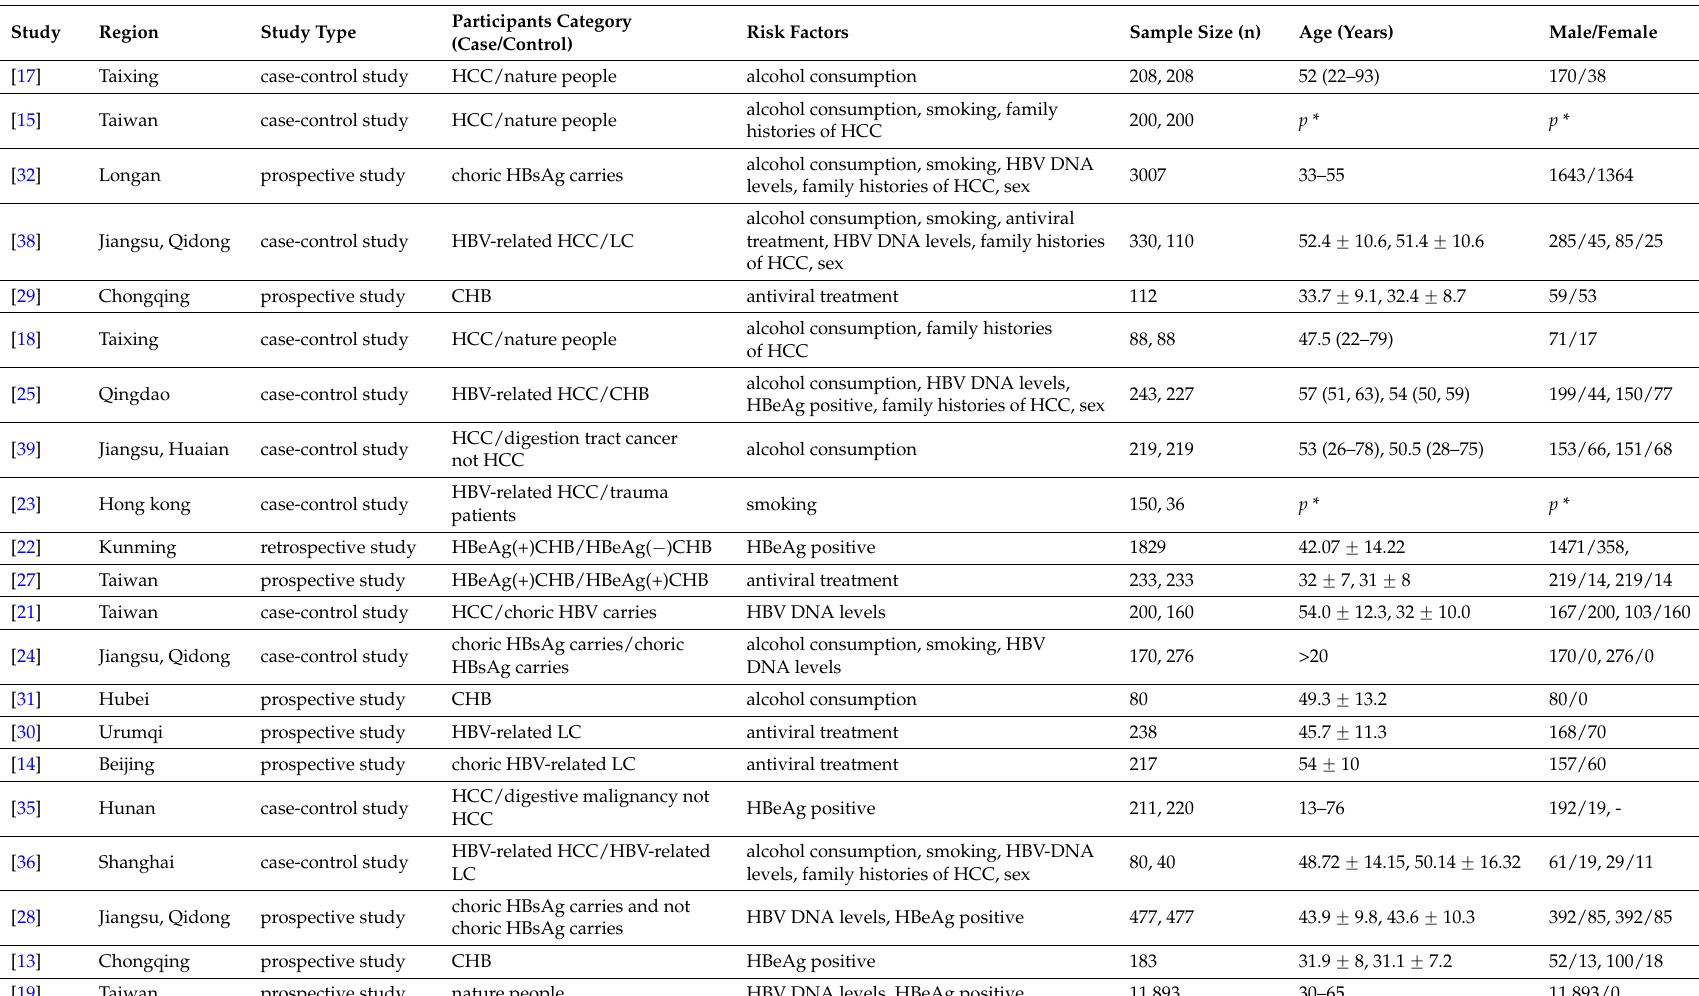
Table 1. Characteristics of the